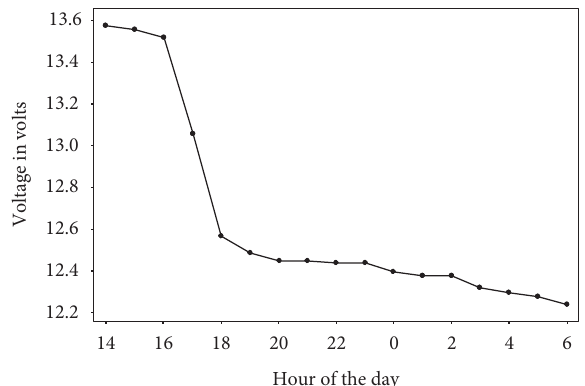
Figure 30: A lead-acid battery voltage discharging curve.